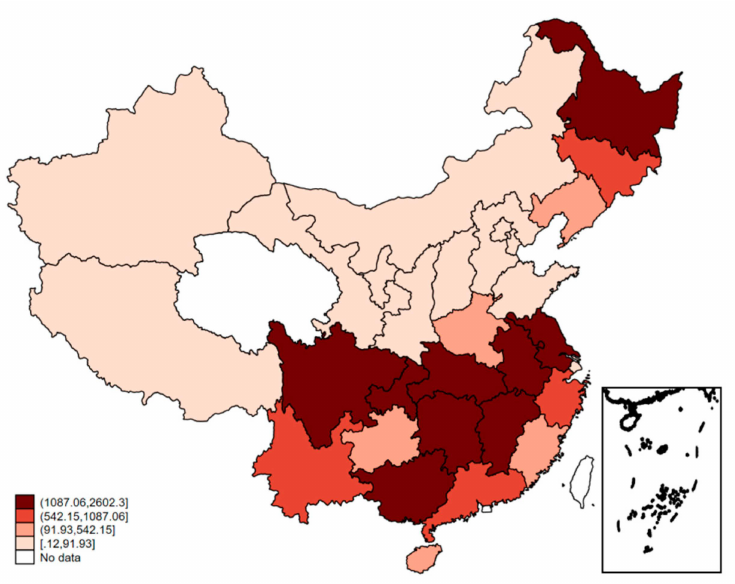
Figure 2. Distribution of rice production across China.